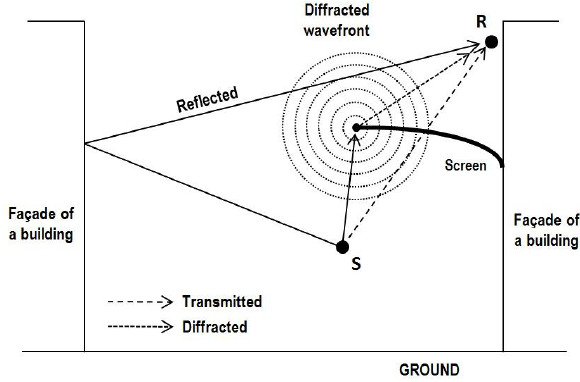
Figure 1: Simplified sketch of the sound components reaching a